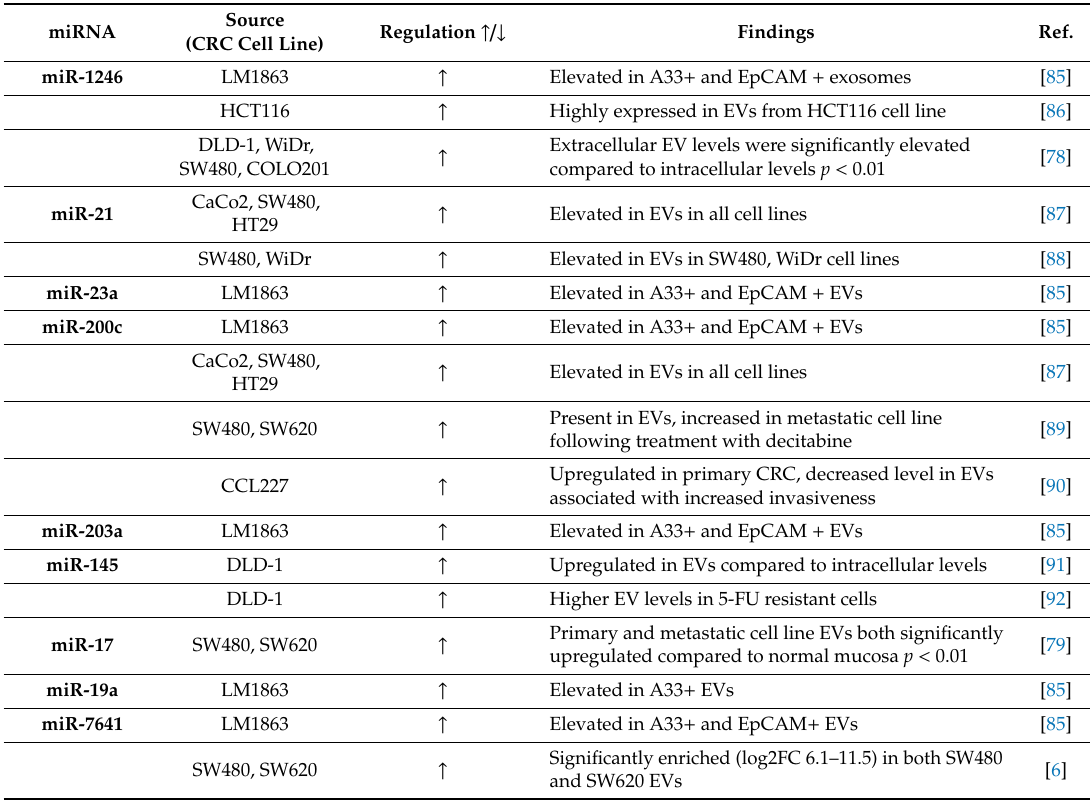
Table 2. EV-miRNAs from in-vitro colorectal cancer (CRC) cell